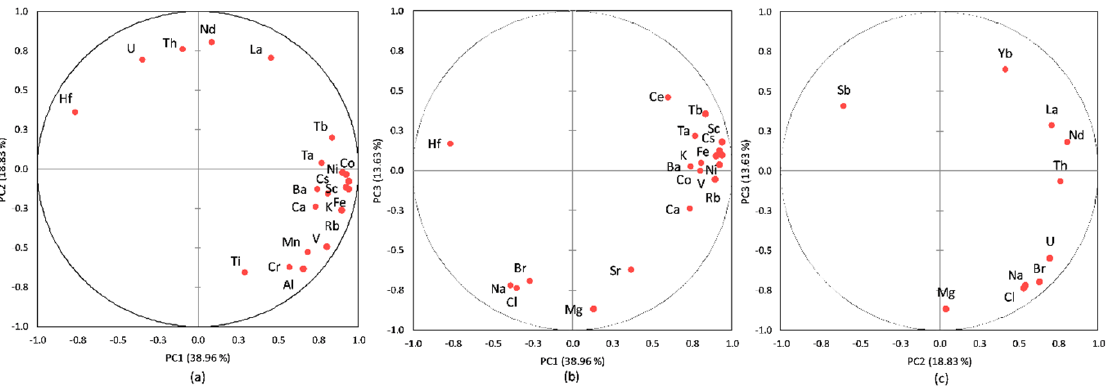
Figure 27. PCA box plots, PC1 versus PC2 ( a ), PC1 versus PC3 ( b ), and PC2 versus PC3 ( c ) obtained for quantified elements in sediment sample of Movila Miresii Lake.